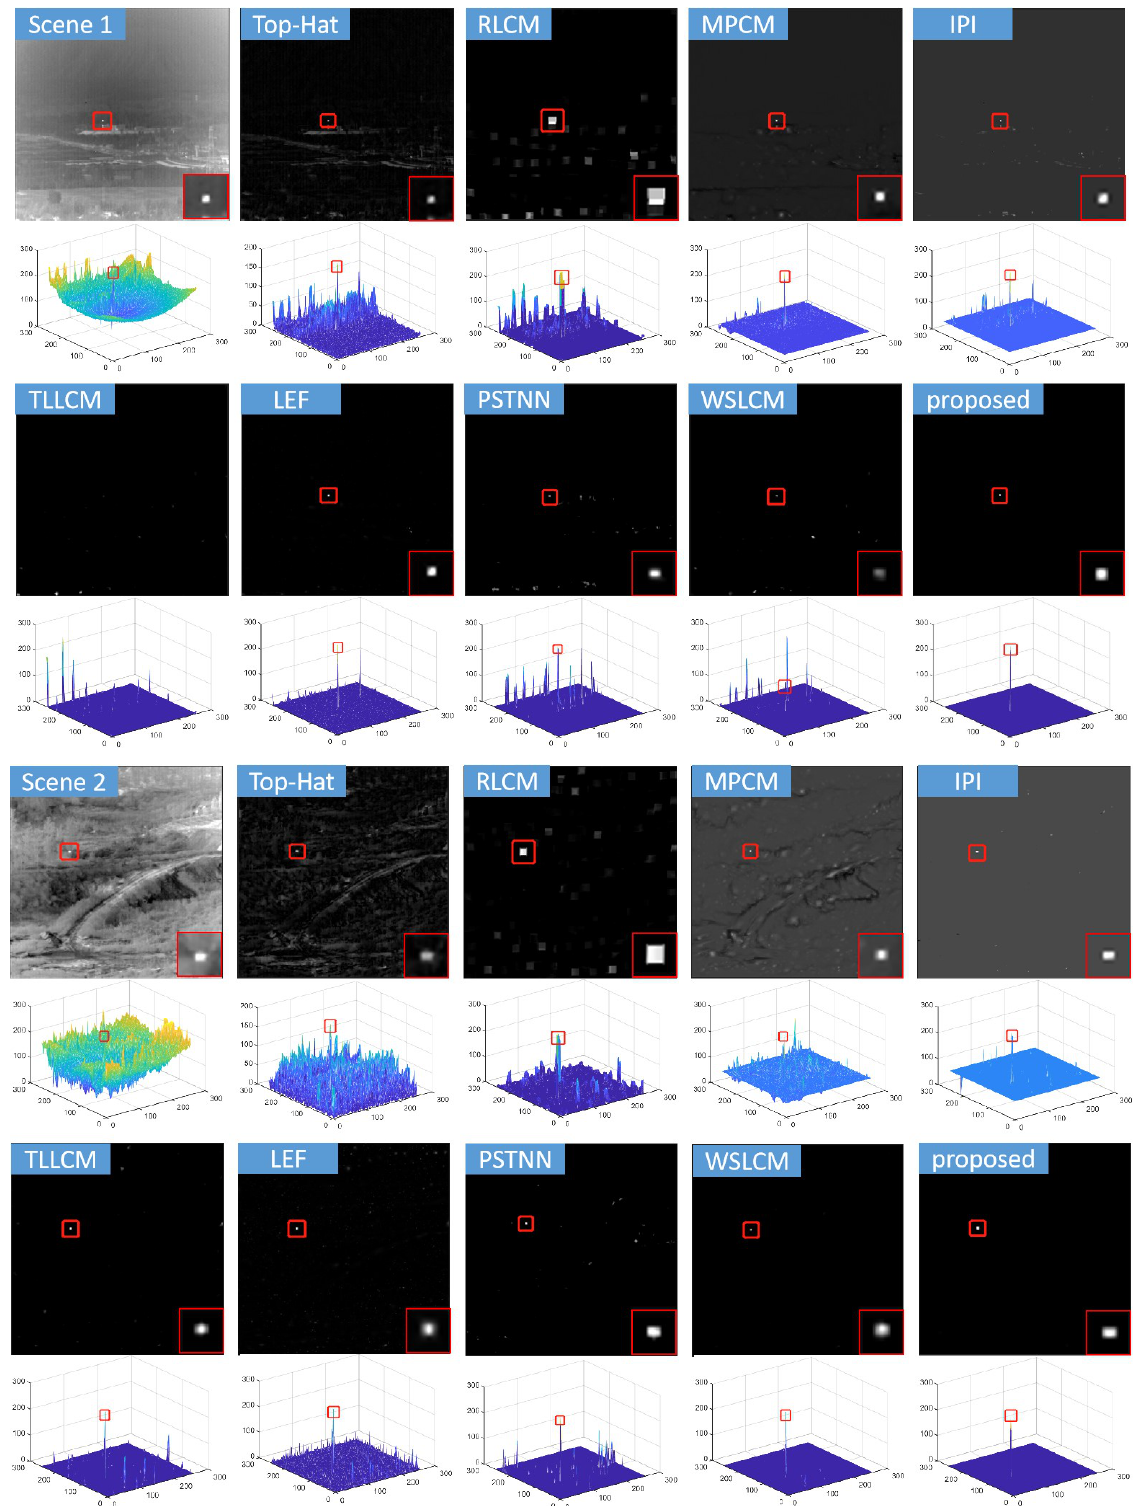
Figure 5. Detection results and 3D distribution of different methods in Scenes 1 and 2. The target is marked with a red box, and a close-up of the target is shown in the lower right corner. Unmarked areas indicate the absence of detection of the